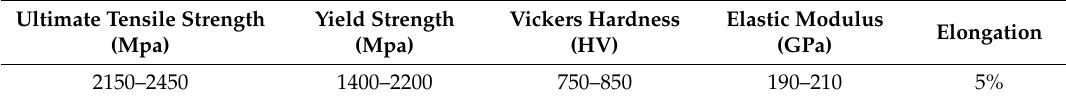
Table 2. Mechanical properties of AISI 52100